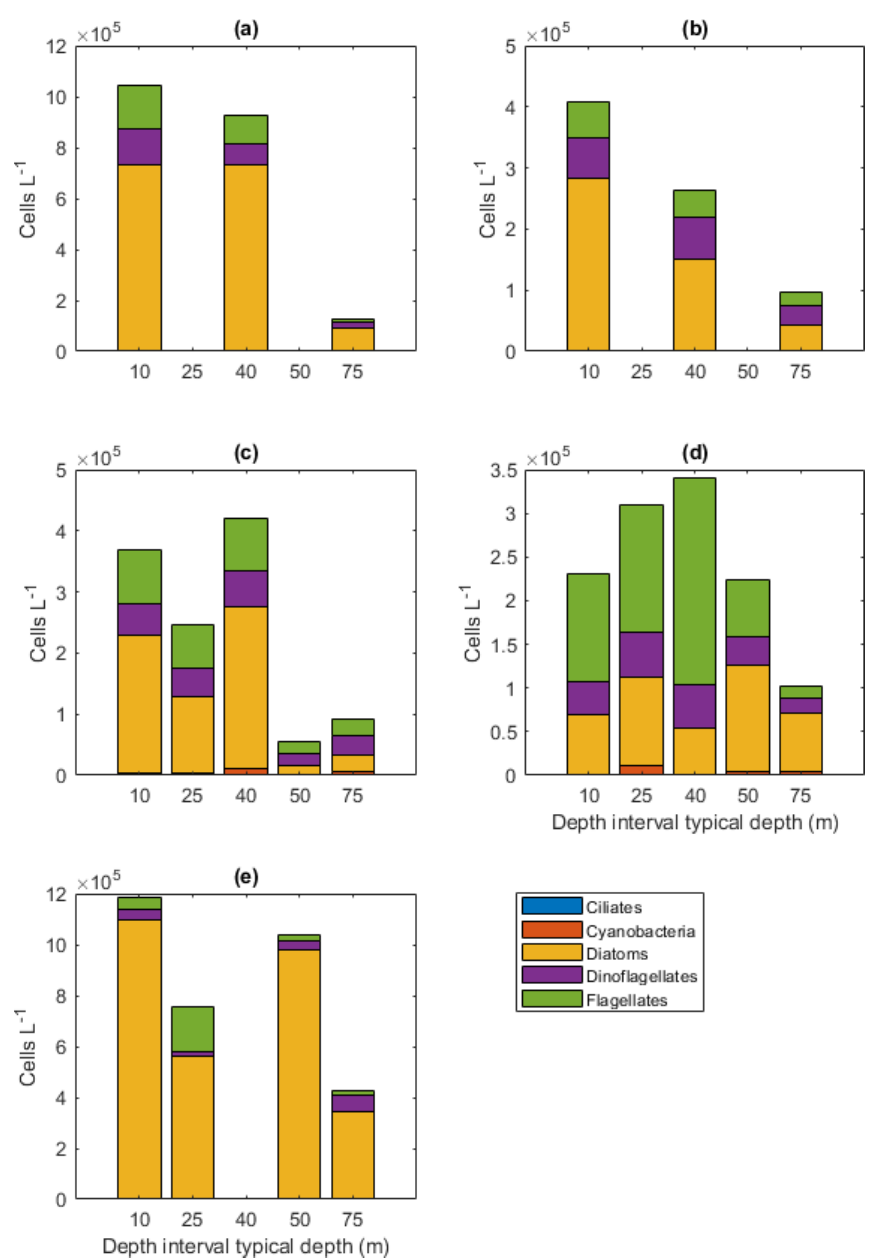
Figure A6. Protist abundances in the different sampling areas averaged per depth interval for (a) station 53, (b) station 54, (c) Astrid Ridge, (d) the 6 ◦ E transect, and (e) Maud Rise. Depth intervals (with typical sampling depth in brackets): 5–10 (10), 25–35 (25), 35–45 (40), 50–60, and 65–85